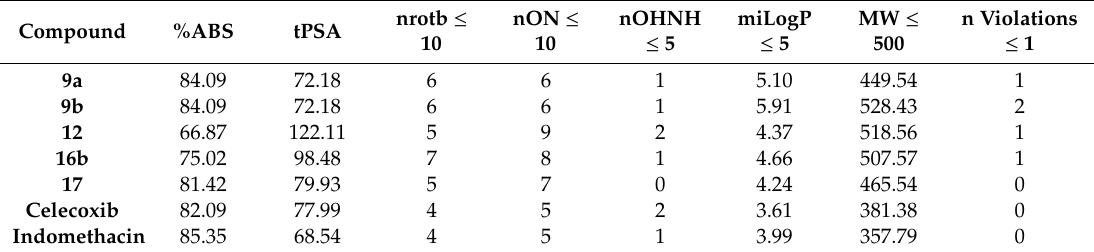
Table 5. The physicochemical parameters of 9a , 9b , 12 , 16b , 17 , celecoxib, and